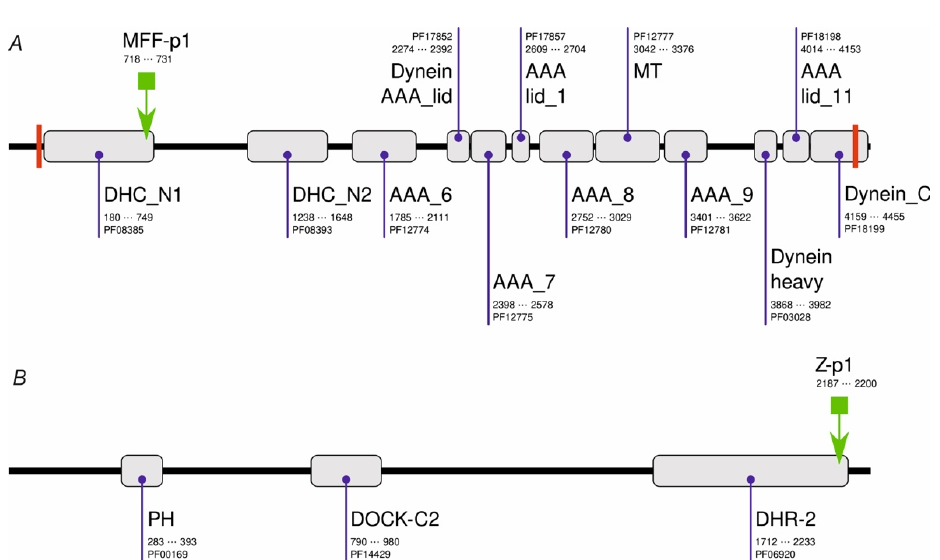
Figure 1. Domain architecture of MFF-kl2 ( A ) and Zizimin ( B ) of Drosophila melanogaster . PFAM domains are shown as gray boxes together with their names, PFAM accession codes, and alignment positions in protein sequences. Transmembrane helices are shown as red bars. The locations of MFF-p1 and Z-p1 are shown with the green